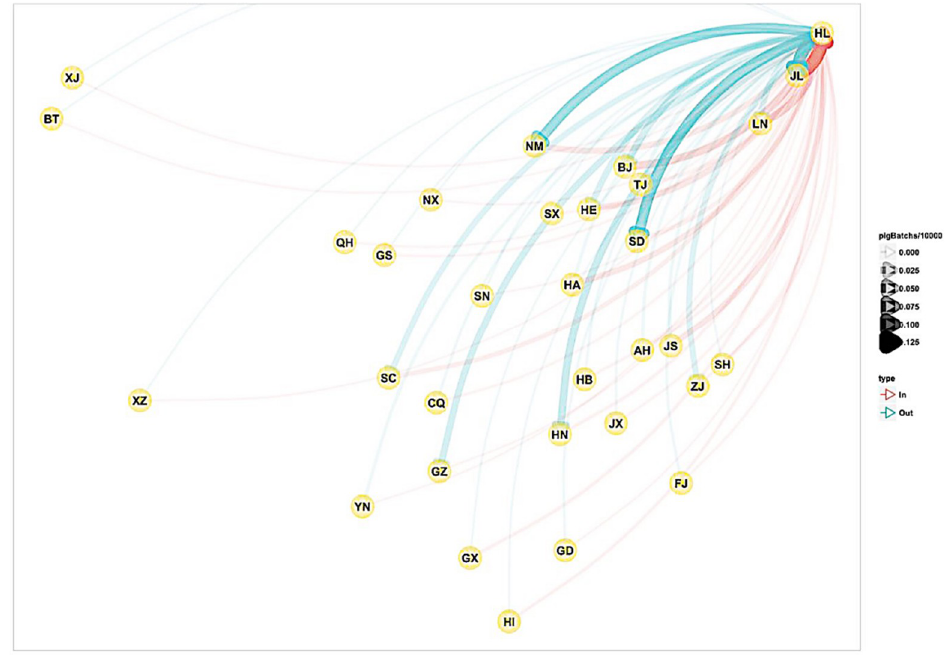
Figure 6. Live pig operation map (the letters in the figure represent abbreviations of China provinces) provided by the China Center for Animal Health and Epidemiology.